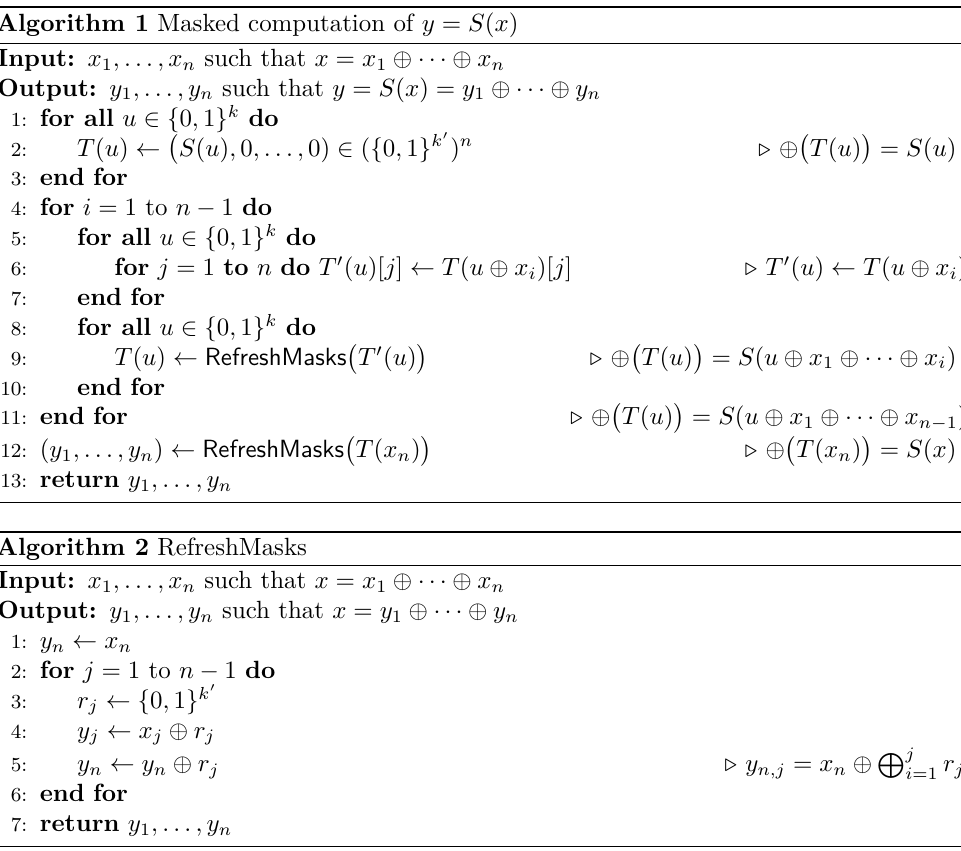
Algorithm 1 Masked computation of y = S ( x )